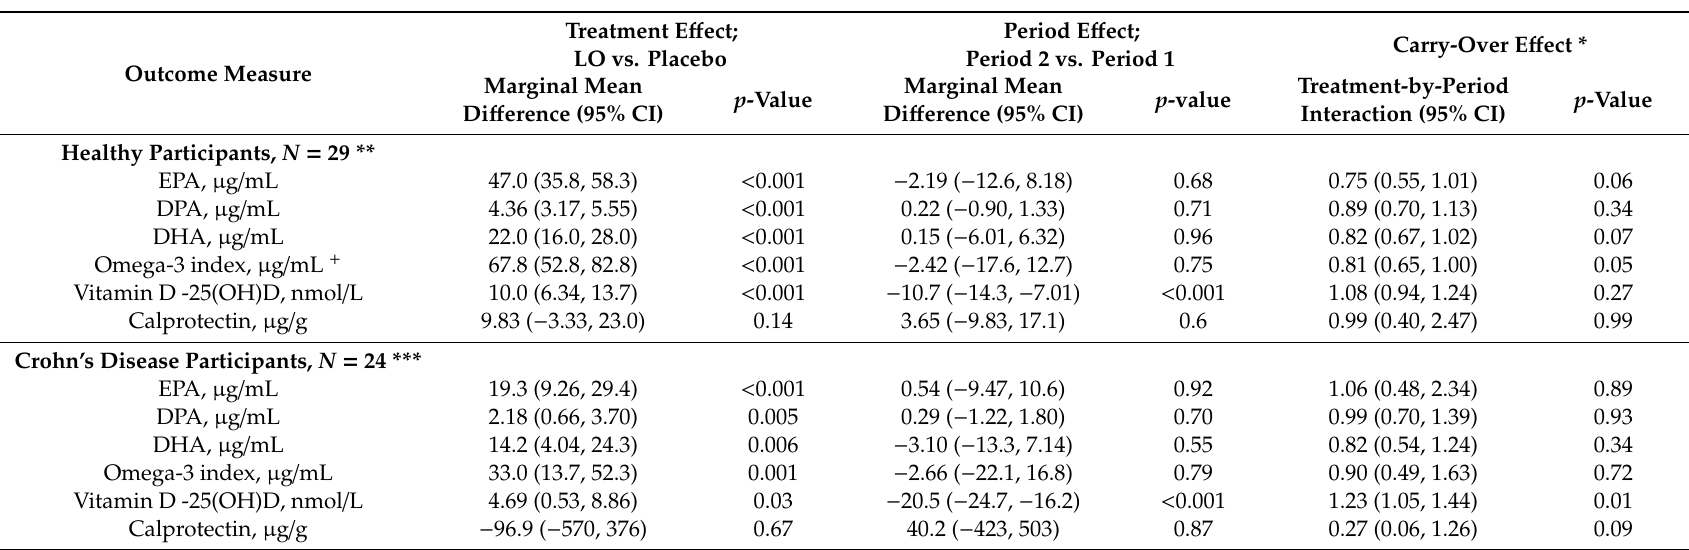
Table 4. Results for analysis of treatment e ff ects on outcome measures using generalized linear mixed models adjusted for average baseline values.